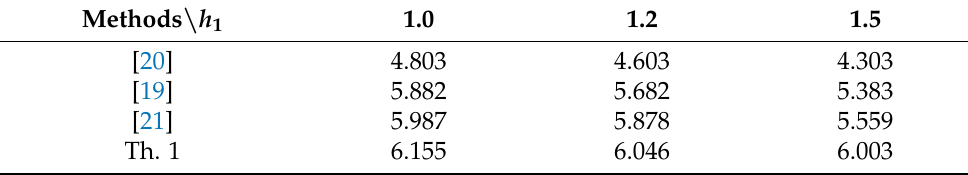
Table 2. MAUBs h 2 for given h 1 , K P and K I under one-area LFC